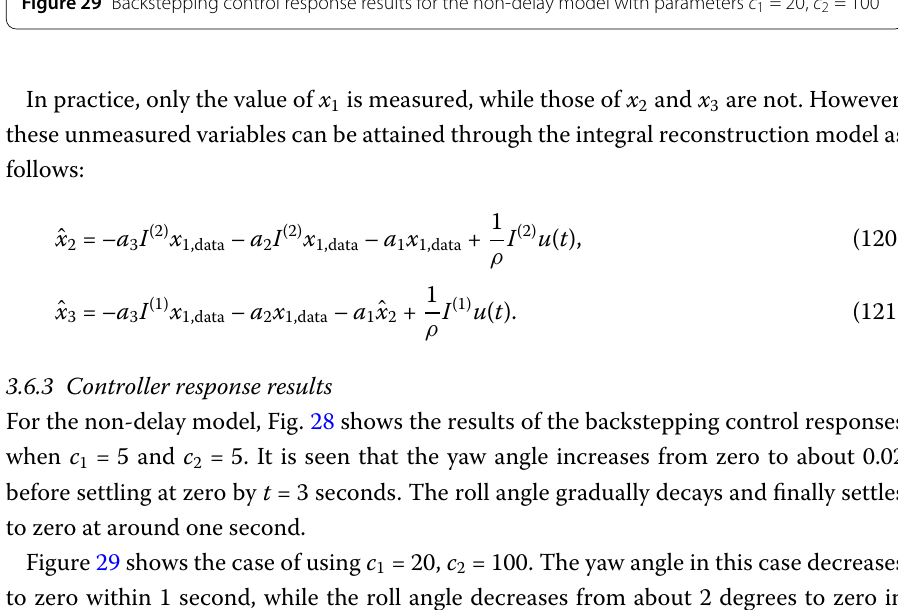
Figure 29 Backstepping control response results for the non-delay model with parameters c 1 = 20, c 2 =